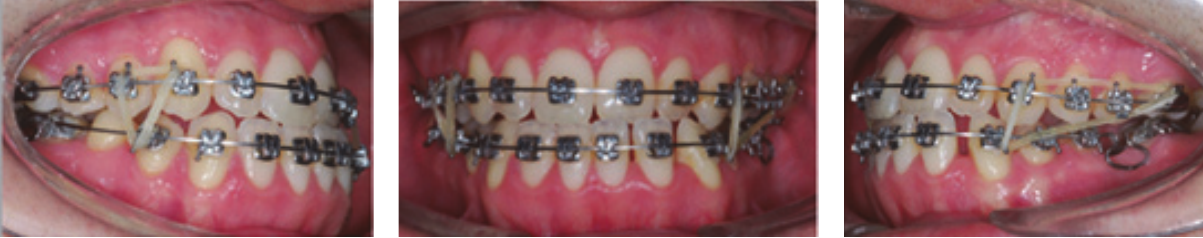
Figure 4: Intraoral views of treatment. Bonding the lower incisor, intermaxillary elastics, and loop to start closure extraction space.